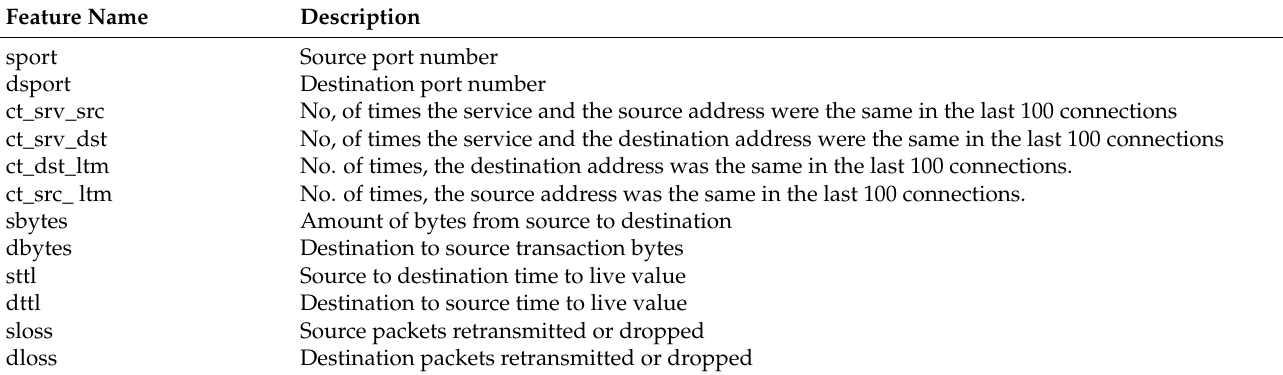
Table 2. Integer-based features.